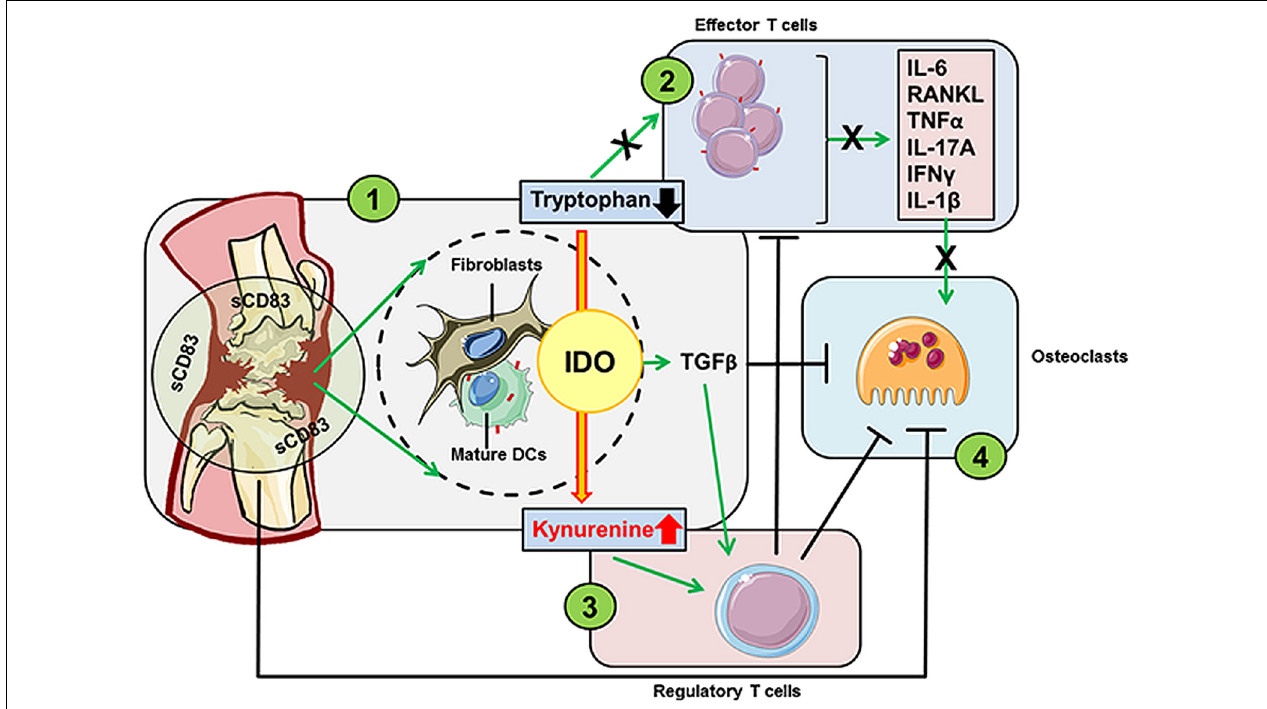
FIGURE 5 | sCD83 has strong modulatory capacities in the murine AIA model for RA. sCD83 within the synovial cavities has four major striking effects on the pathogenesis of arthritis: (1) sCD83 induces both, the enzymatic and signaling activity of IDO in DCs as well as synovial fibroblasts. IDO leads to local tryptophan degradation and increased kynurenine levels, thereby (2) hampering the proliferation and differentiation of effector T helper cells and the subsequent reduction of proinflammatory cytokine levels. Furthermore, the increasing kynurenine to tryptophan ratio provides an anti-inflammatory environment and (3) promotes the differentiation of Tregs. This effect is further enhanced by TGF β , a key cytokine of the non-canonical signaling pathway of IDO. The induction of TGF β and Tregs, and the reduced levels of proinflammatory cytokines within the knee joints, (4) hamper osteoclast formation and activity. Moreover, sCD83 has a direct inhibitory effect on the